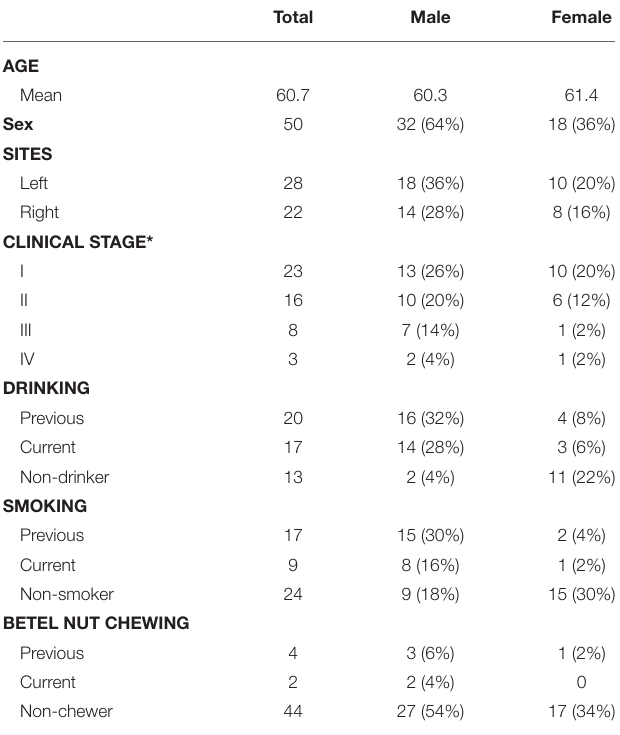
TABLE 1 | Clinical characteristics of